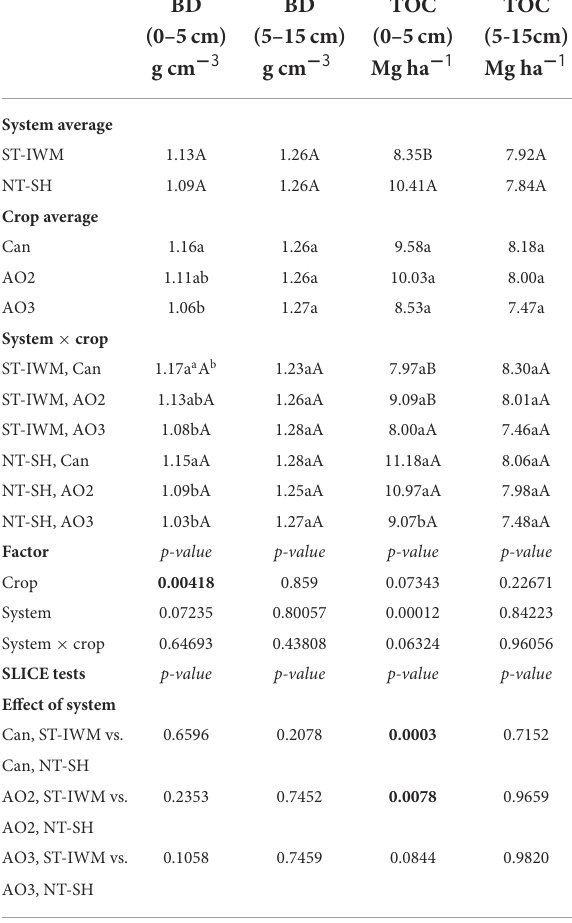
TABLE 3 Bulk density and TOC by volume averages at 0–5 and 5–15cm depths for strategic tillage within integrated weed management (ST-IWM) and continuous no-till with standard herbicide (NT-SH) in canola (Can), second-year alfalfa orchardgrass (AO2) and third-year alfalfa orchardgrass (AO3) crops sampled in